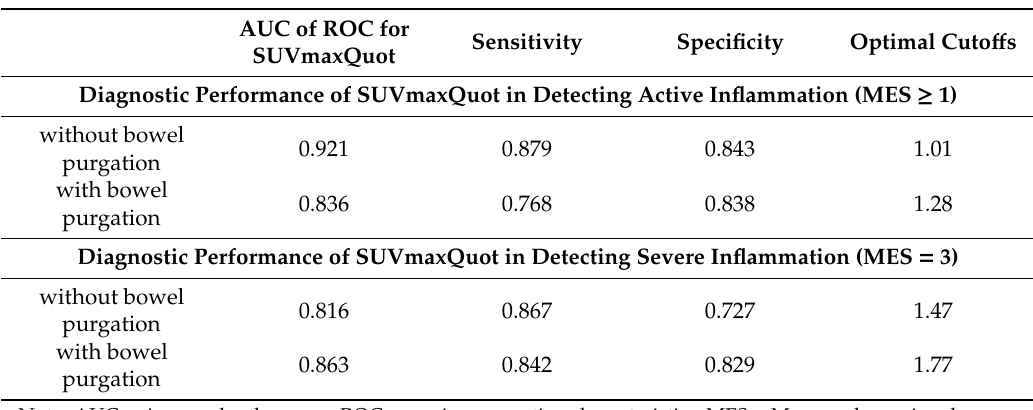
Table 3. Diagnostic performance of SUVmaxQuot in detecting endoscopically active and severe inflammation with and without